Question: Summarize what this figure shows in one sentence.
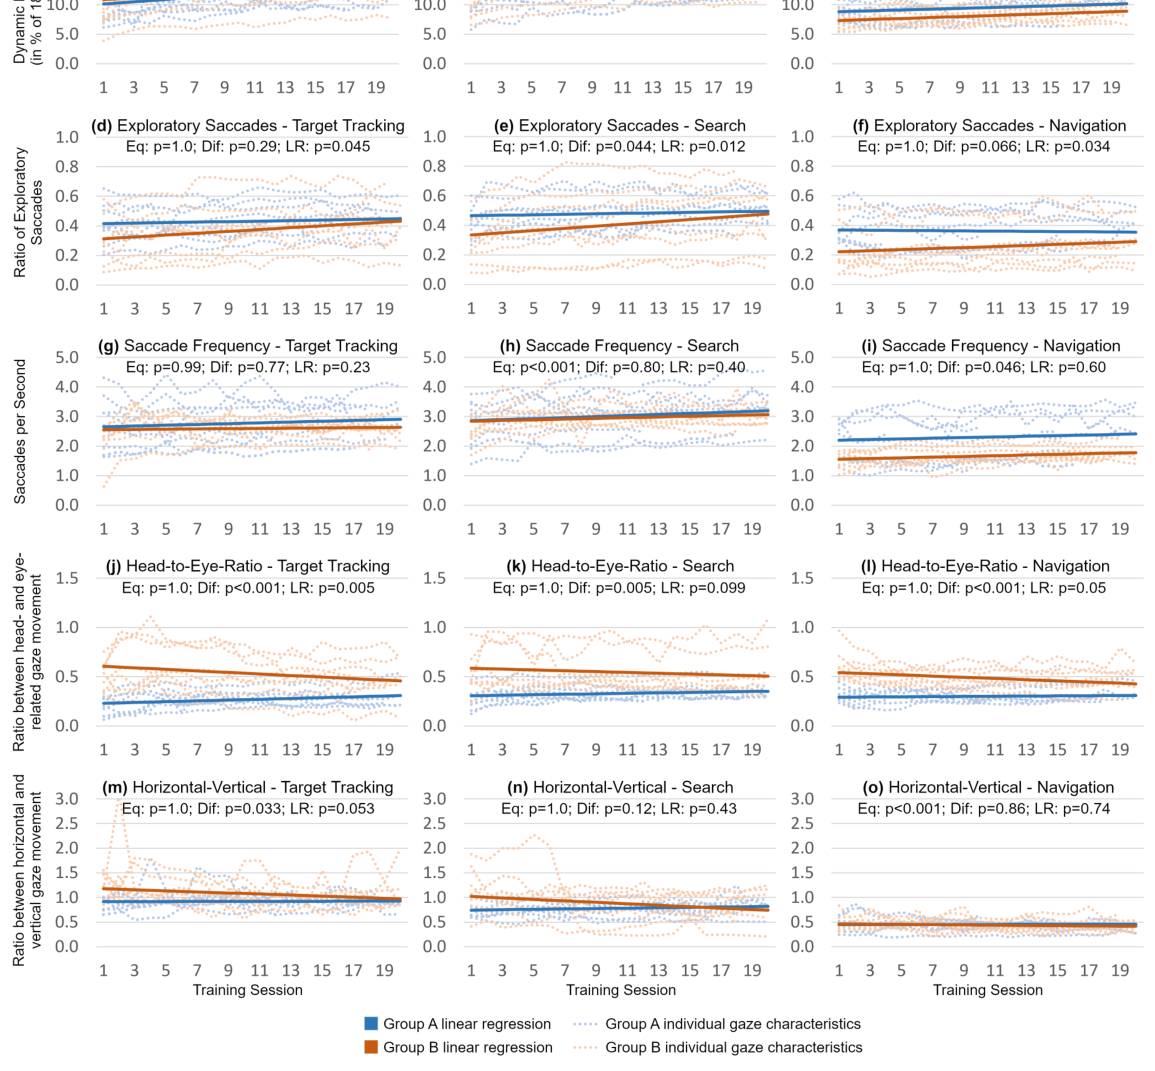
Answer: Results of the gaze characteristic parameters in the three different visual tasks, showing individual results of participants and average regression for Group A and B. Each plot includes the resulting p-values of the statistical models conducted: Eq describes the equivalence between groups found with TOST, Dif describes the effect between groups found with a LMM, and LR describes the interaction effect between the Training Session and Group parameter, meaning differences in the learning rate between groups. Head-to-Eye-Ratio describes the amount of head movement (in visual angles) divided by the amount of eye movement contributing to saccades. Horizontal-to-Vertical describes the amount of gaze movement on the elevation axis divided by the amount of gaze movement on the azimuth axis.